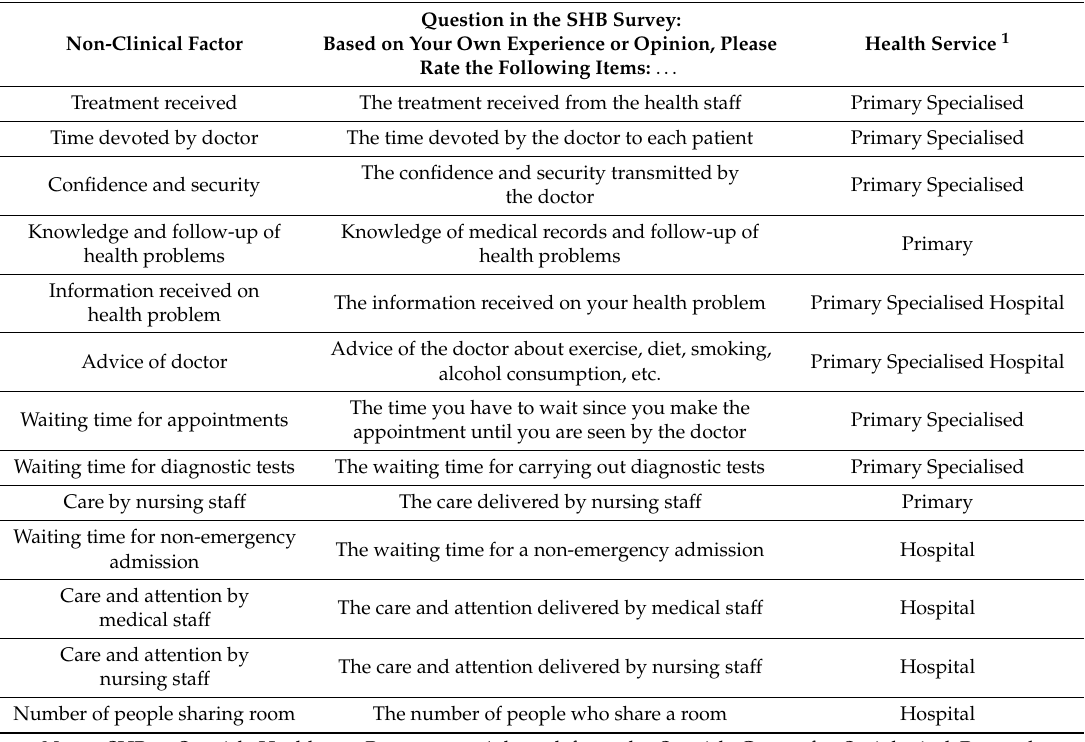
Table 1. Non-clinical factors included in the Spanish Healthcare Barometer by health service in 2015. Question in the SHB Survey: Non-Clinical Factor Based on Your Own Experience or Opinion, Please Rate the Following Items: